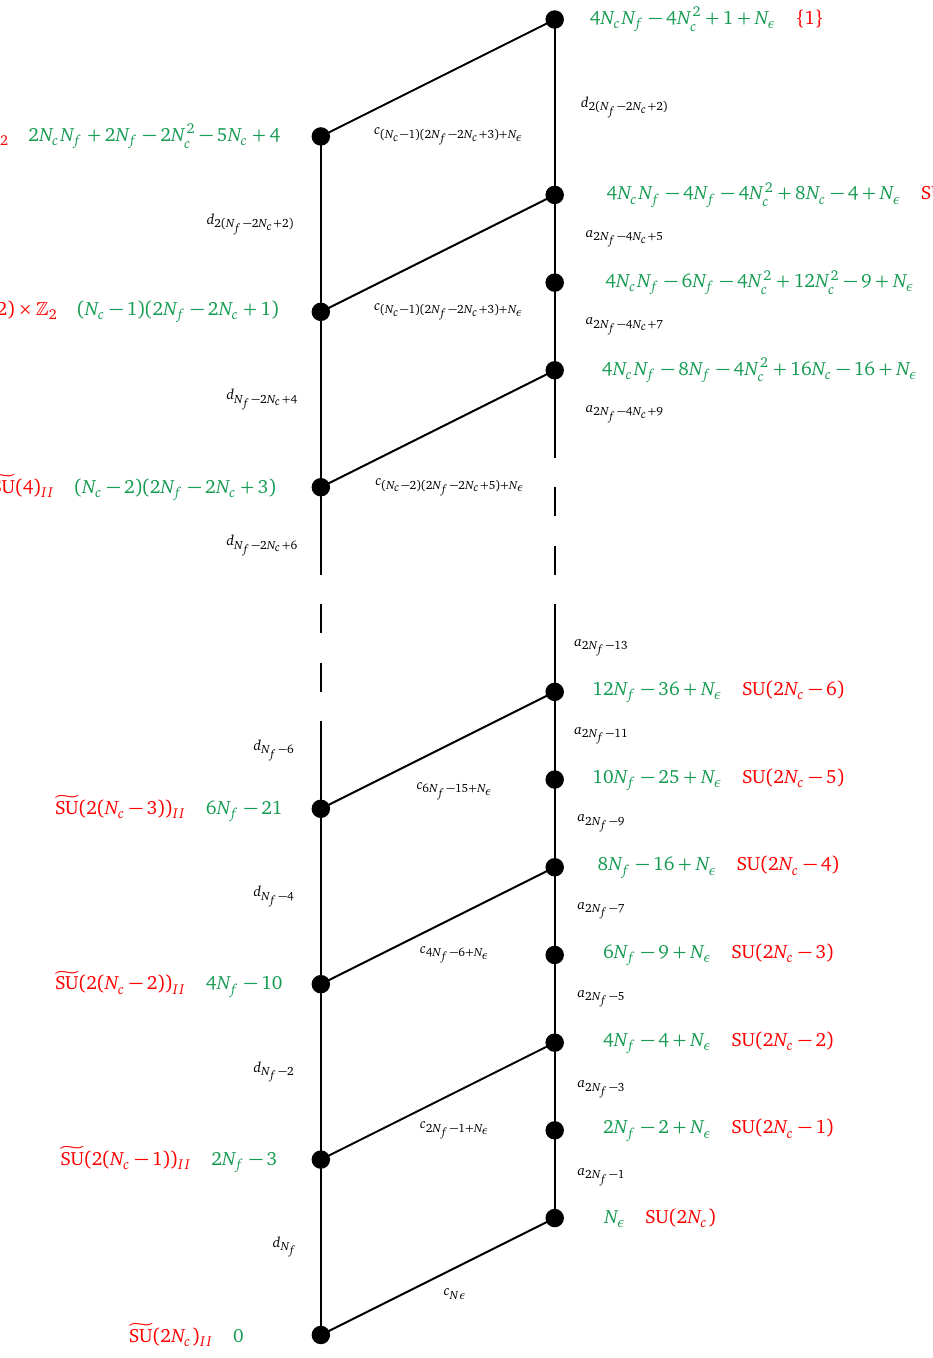
) + N ( F ⊕ F )+ N ε for N ≥ 2 N . ε c II f f c